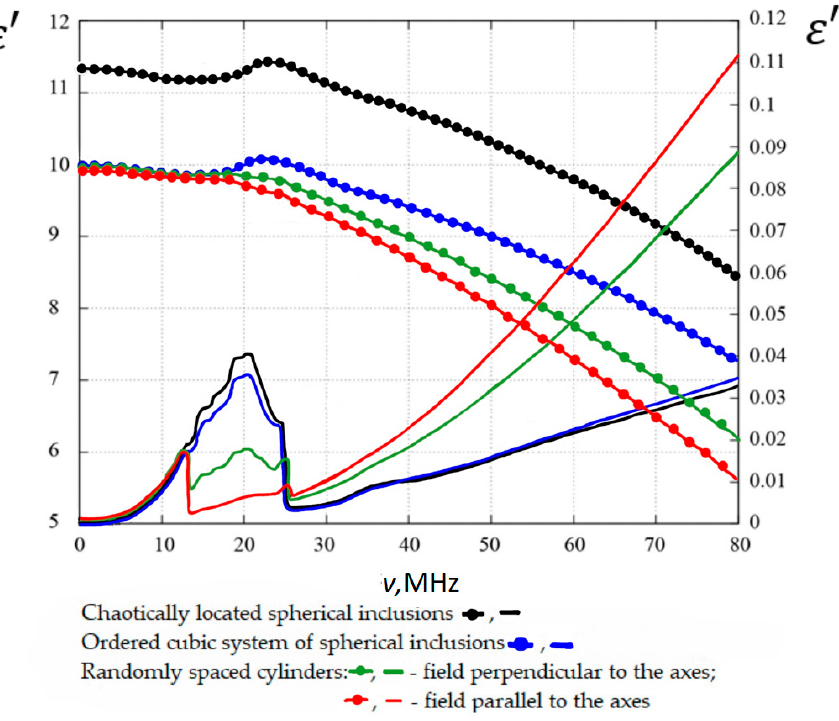
Figure 4. Frequency dependences of the complex permittivity for cylindrical and spherical inclusions B in a matrix Si.